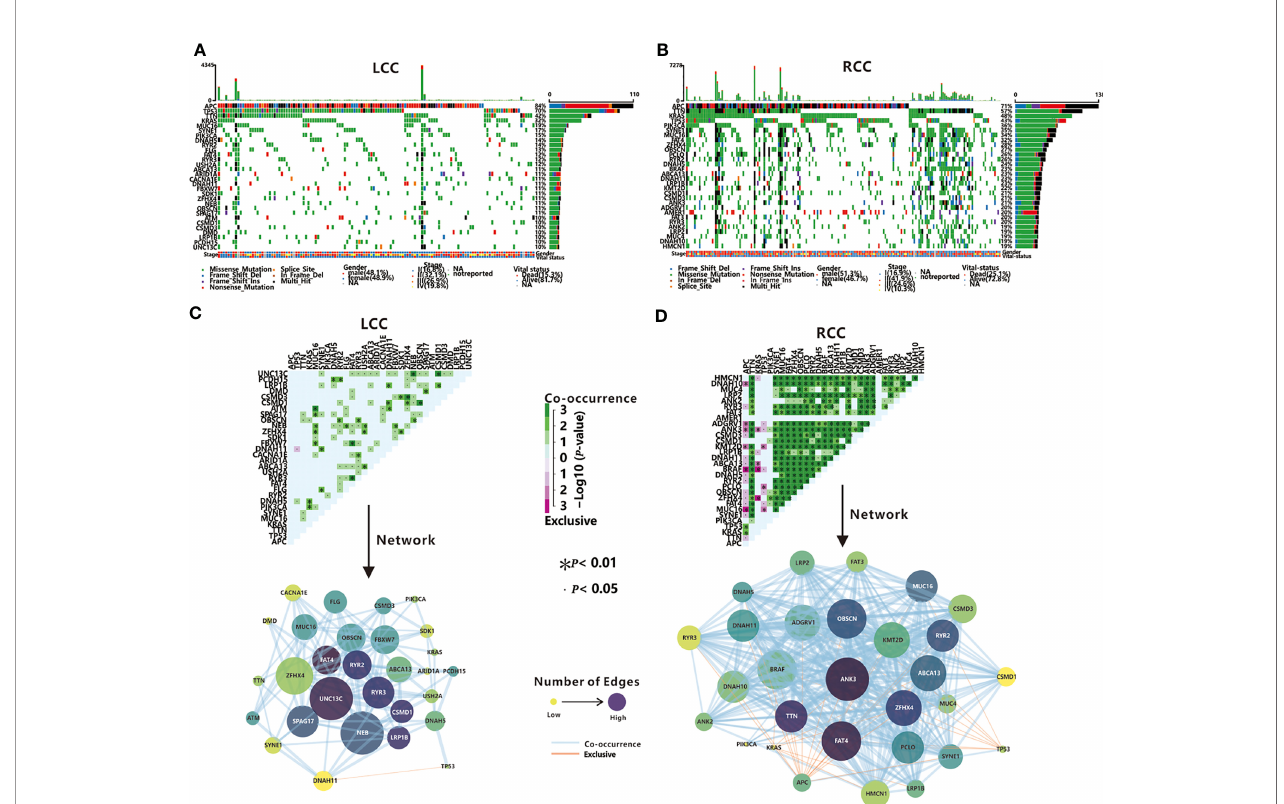
FIGURE 2 | TMGs in LCC and RCC. Waterfall plots show the mutation status (middle)and the mutation rate (right)of each TMG, and the mutation frequency (top), the gender, stage and vital status (bottom) of each patient in LCC (A) and RCC (B) . Mutually exclusive and co-occurring gene pairs (top), and networks of mutational interaction (bottom) in LCC (C) and RCC (D)